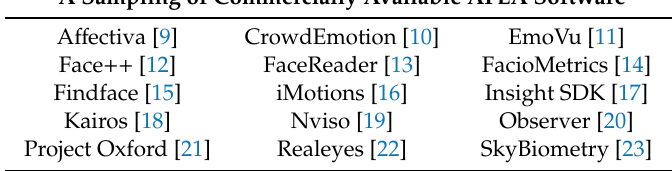
Table 1. Commercially available automated facial expression analysis (AFEA) software as of December